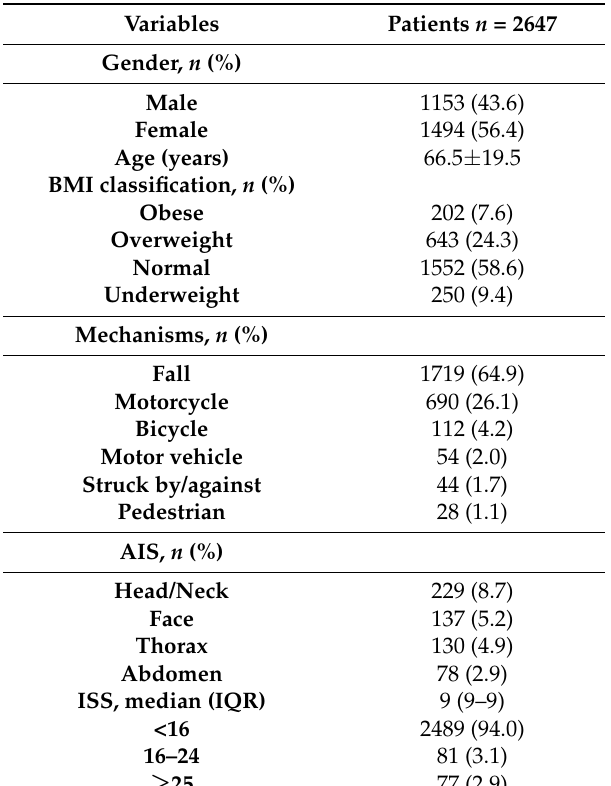
Table 1. Characteristics of patients with femoral